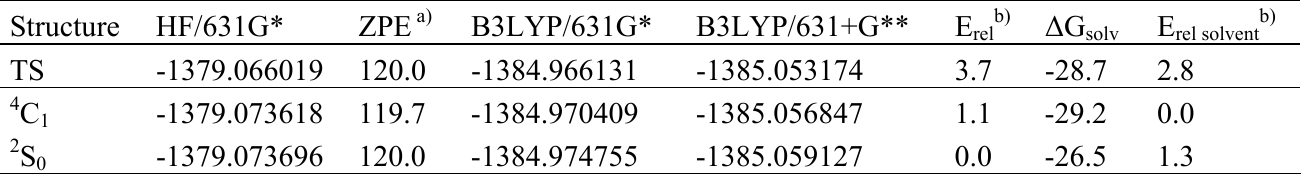
Table 7 . Calculated energies of the H-form of IdoA2-SO gaseous phase and solvatation energies and relative energies [kcal/mol] in water.